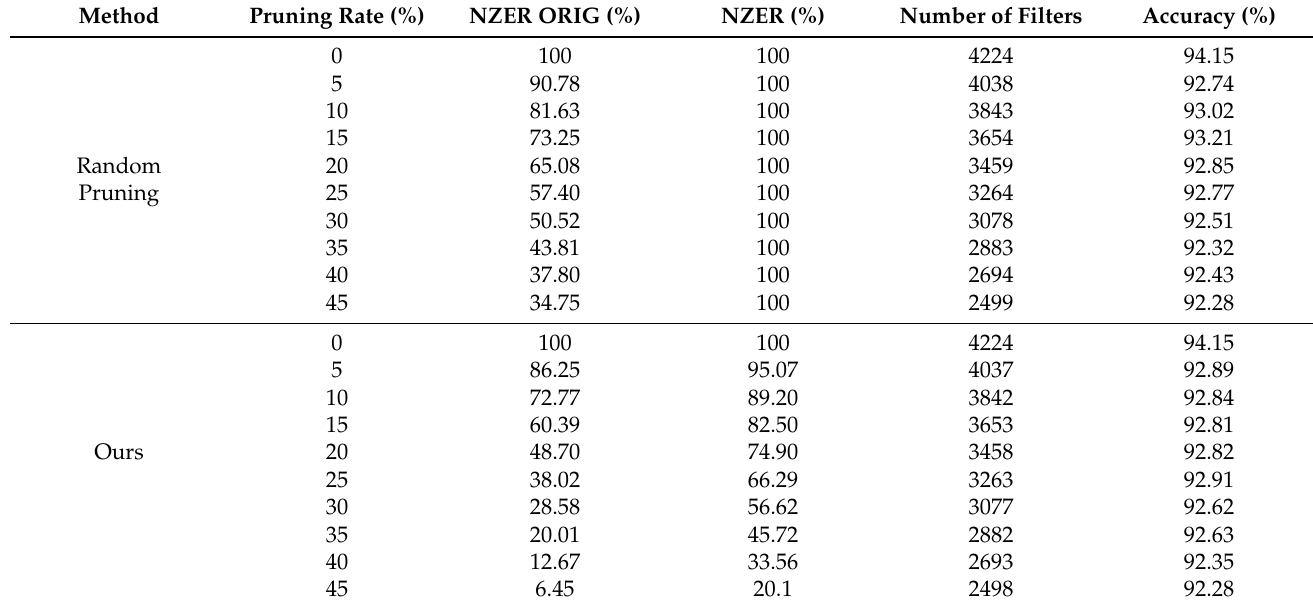
Table 3. Experiment results of filter pruning on the layers from the 5th to the 13th on VGG-16.